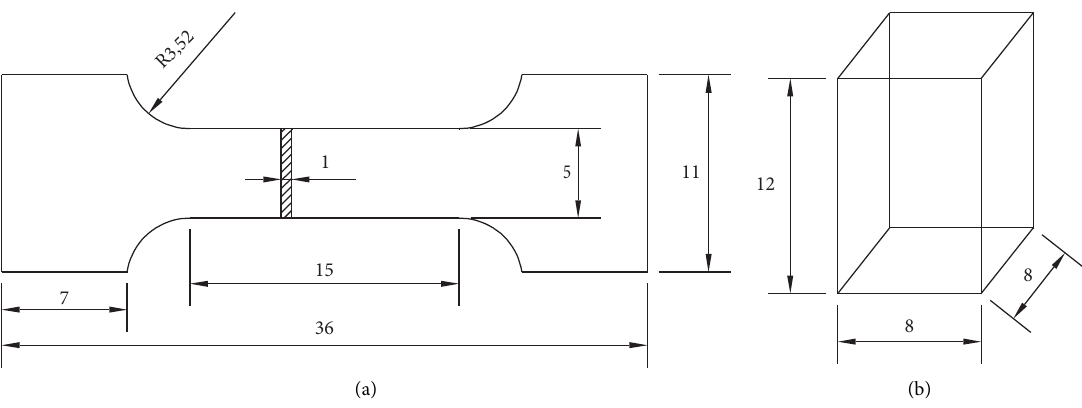
Figure 2: Sample shape and size: (a) tensile sample; (b) compression